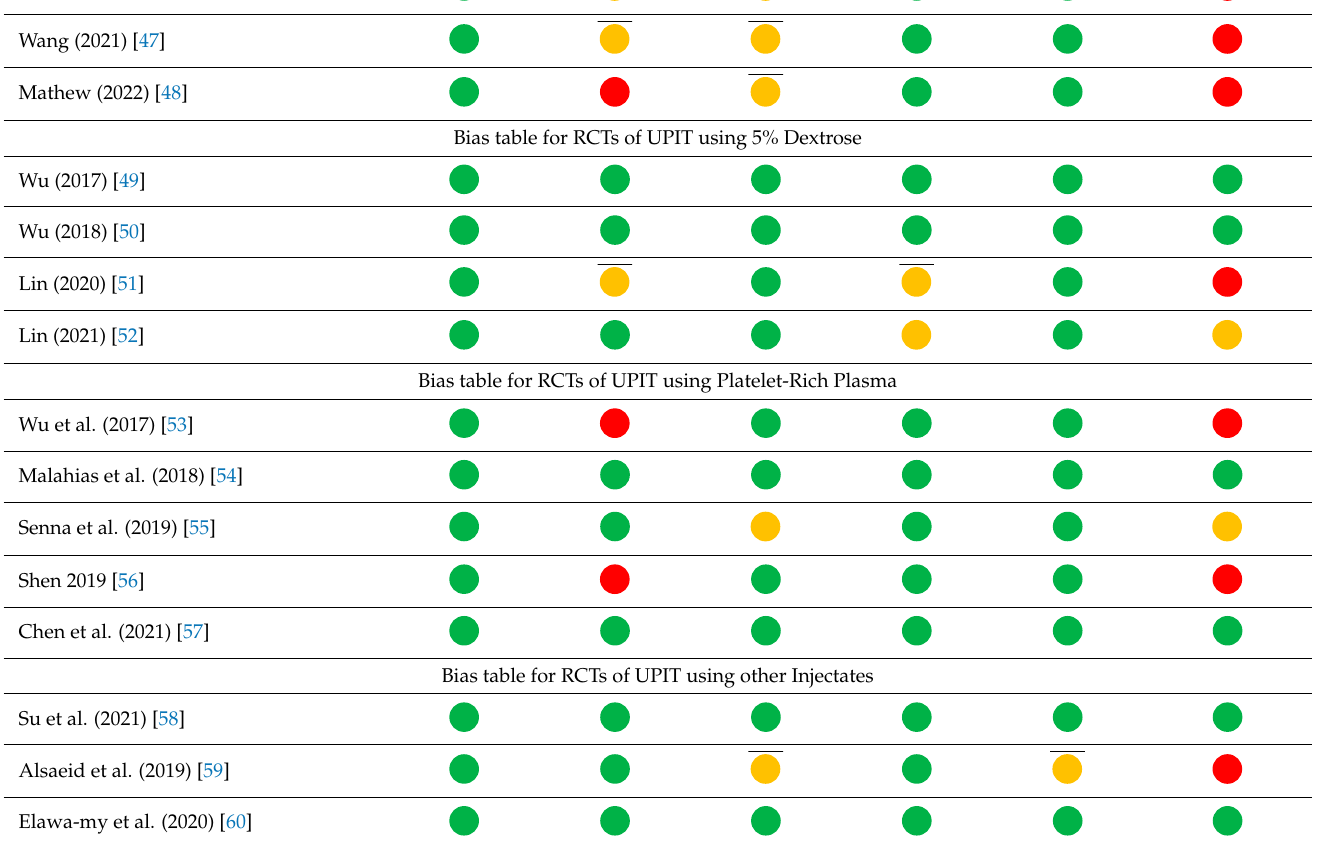
Table 1. Bias table for RCTs of UPIT and UPCTR.